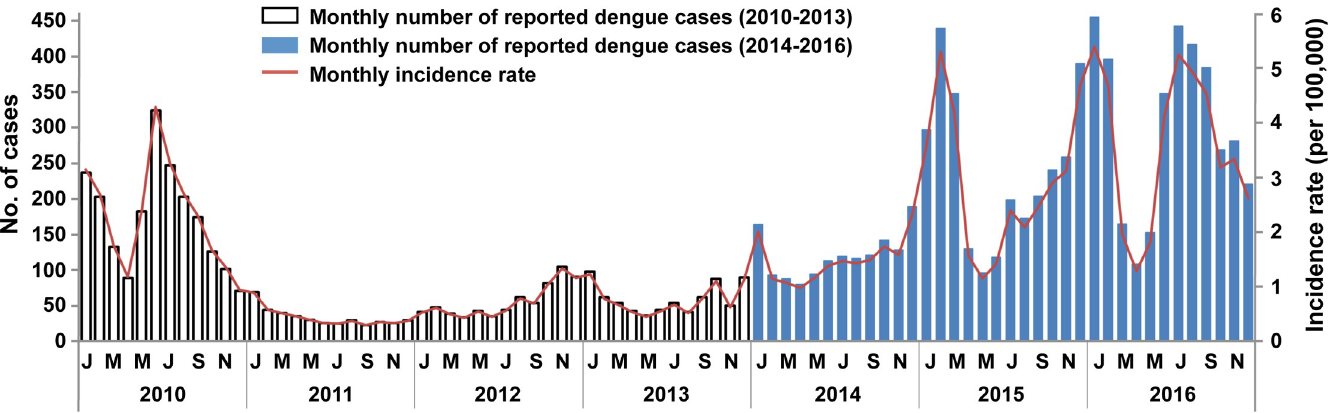
Fig 2. Temporal pattern of dengue in Sabah, 2010–2016. The monthly number of reported dengue cases per year are shown (primary vertical axis), and the corresponding monthly incidence rate (secondary vertical axis). Grey bars indicate the years 2010–2013 where case diagnoses were predominantly clinically-based (with or without laboratory confirmation), and blue bars indicate notifications following the 2014 change in case definition, where all cases were laboratory